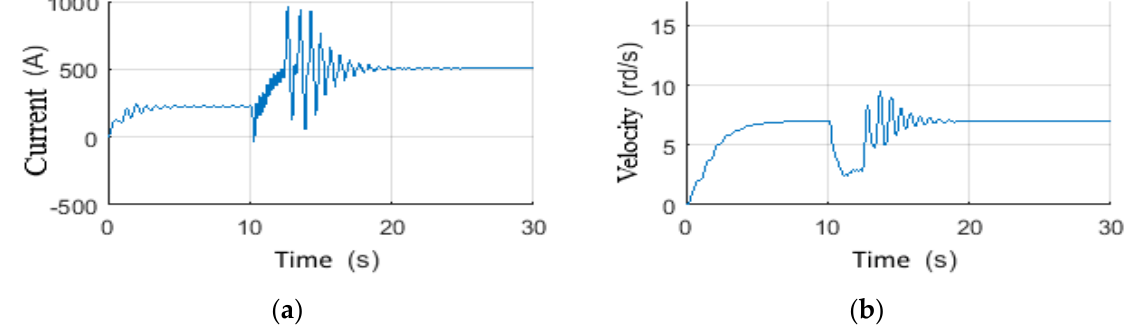
Figure 29. Observer-based controller responses for Scenario-8: ( a ) Velocity, ( b ) Voltage.